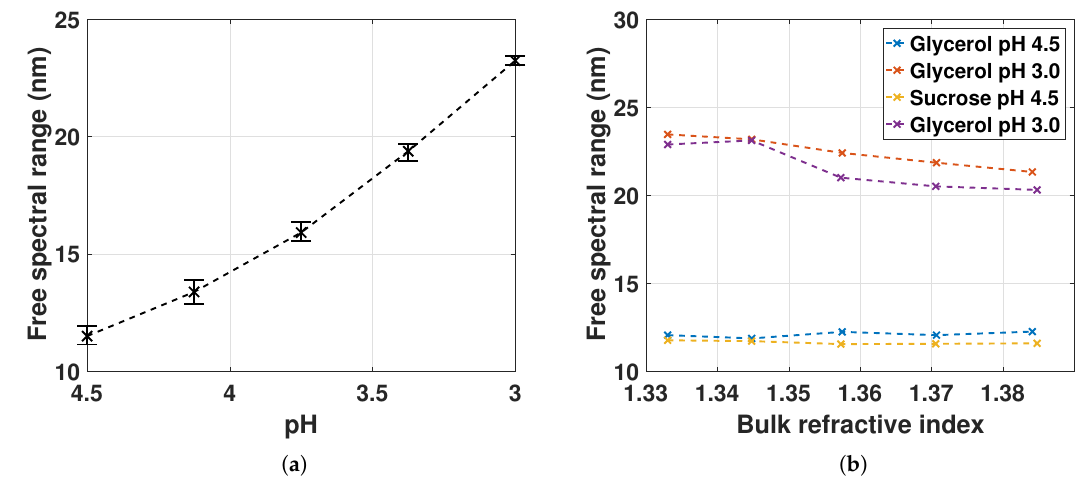
Figure 6. ( a ) FSR measured for the hydrogel deswellling from pH 4.5 to 3.0 for two sampled series with mean, minimum and maximum values from 4 sampled FSRs; ( b ) FSR measured for increasing bulk RI with pH 4.5 and 3.0 for one sampled